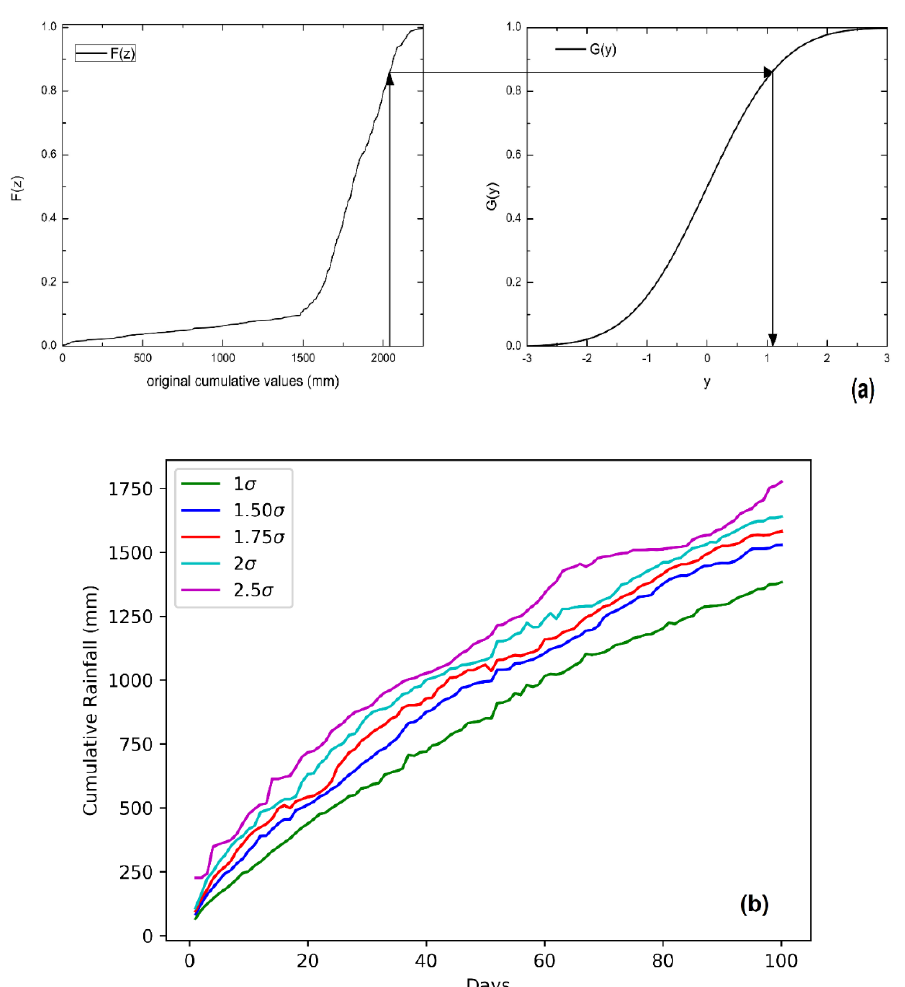
Figure 4. ( a ) Transformation of original cumulative distribution in the target distribution for Kalimpong town; ( b ) An example of SIGMA (sistema integrato gestione monitoraggio allerta—integrated system for management, monitoring and alerting) curves ( σ curves) for cumulative periods up to 100 days (2010–2015).